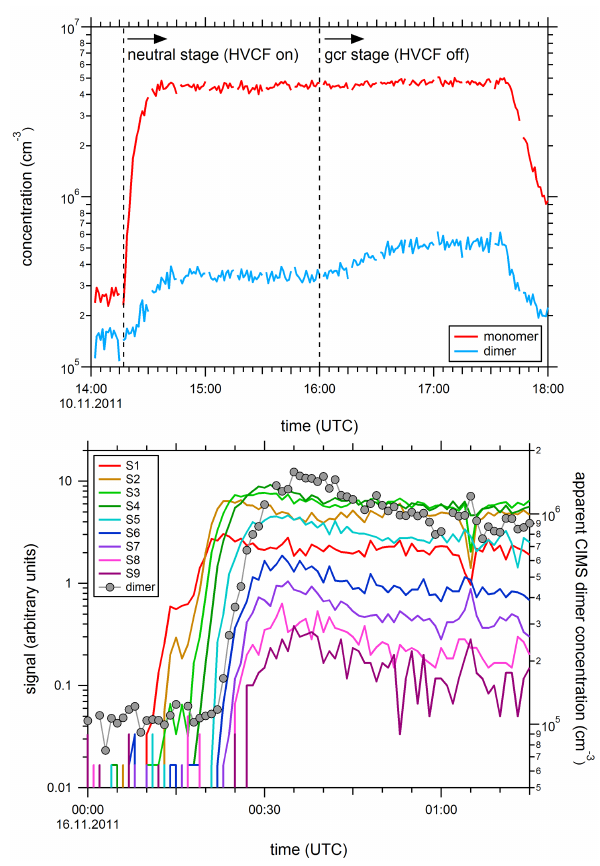
Figure 2. Upper panel: observed ion effect on CIMS sulfuric acid dimer ( m/z 195) measurements at 223K. The first part of the ex- periment is under neutral conditions, whereas the second part is a GCR run with ions present in the chamber. The increase in the dimer signal during the GCR stage is due to ions detected by the CIMS and not due to neutral dimers. Lower panel: comparison be- tween the APi-TOF signals and the CIMS dimer measurements for a different ion-induced experiment at 223K. The ion clusters (S6, i.e., HSO − (H 2 SO 4 ) 5 and larger) show a clear correlation with the 4 apparent dimer signal, which indicates that fragmented cluster ions contribute to the CIMS dimer measurement (Pearson’s correlation coefficient between dimer and S6 is